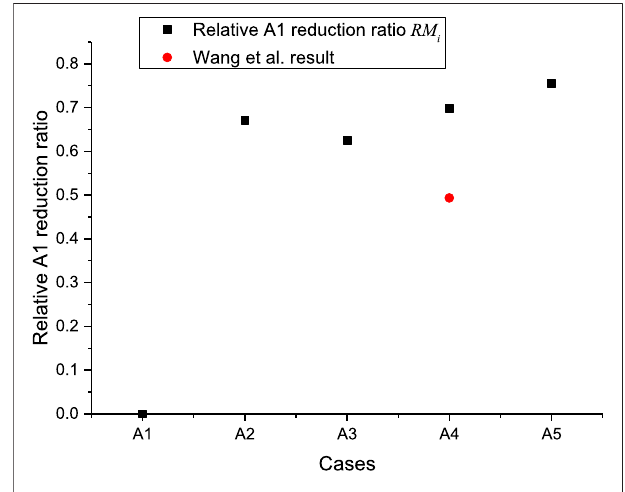
FIGURE 5 | The relative reduction ratio RM i of average snow mass on the six bogies in different cases over that of the original case (A1).